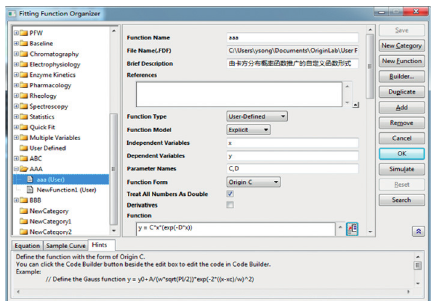
Figure 14: Origin software used to verify reliability of the mathematical model.